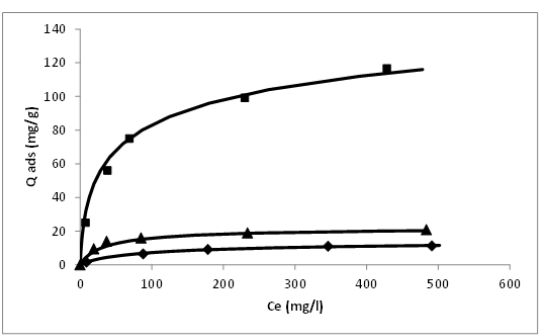
Figure 6. Adsorption isotherm of Chromium over different AC( (cid:31) :H 2 SO 4 , (cid:29) :ZnCl 2 , (cid:30) :NaOH)